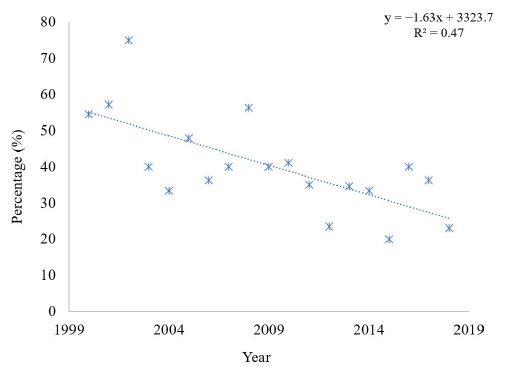
Figure 3. Percentage of deaths of paediatric CF patients in the 2000–2018 period.